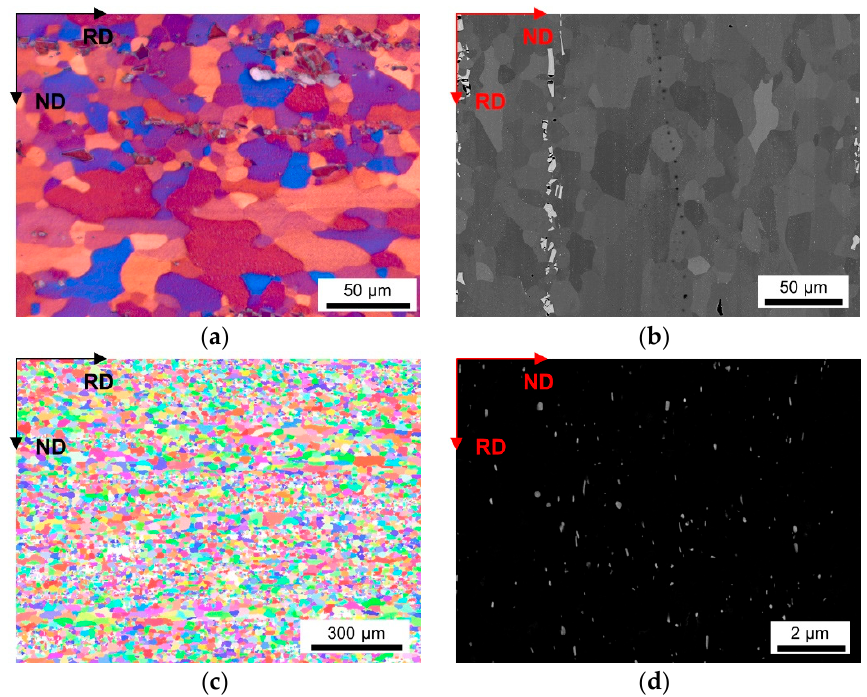
Figure A24. Microstructure of the soft annealed HFe-HMn cast under S-C conditions, homogenized at 500 °C and cold rolled to a CRD of 35%. ( a ) LOM. ( b ) BSE image. ( c ) EBSD IPF map in RD–ND plane. ( d ) BSE micrograph showing dispersoids.